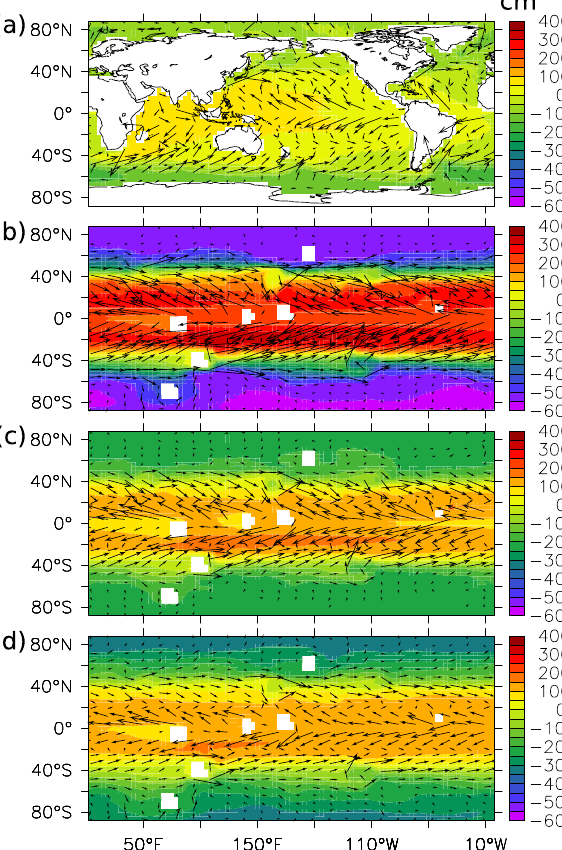
Fig. 14: Oceanic surface velocities (arrows) on top of sea-surface height anomalies (colour shading) Fig. 14. Oceanic surface velocities (arrows) on top of sea-surface for (a) the pre-industrial climate state and the three early Archean states (CO 2 partial pressure height anomalies (colour shading) for the pre-industrial climate state (a) and the three early Archean states – CO 2 partial pressure of 0.4, 0.6 and 0.8 bar in panel (b), (c) and (d) respectively). The relative lengths of the arrows of 0.4, 0.6 and 0.8bar in (b) , (c) and (d) respectively. The relative correspond to the relative magnitudes of the velocities. lengths of the arrows correspond to the relative magnitudes of the